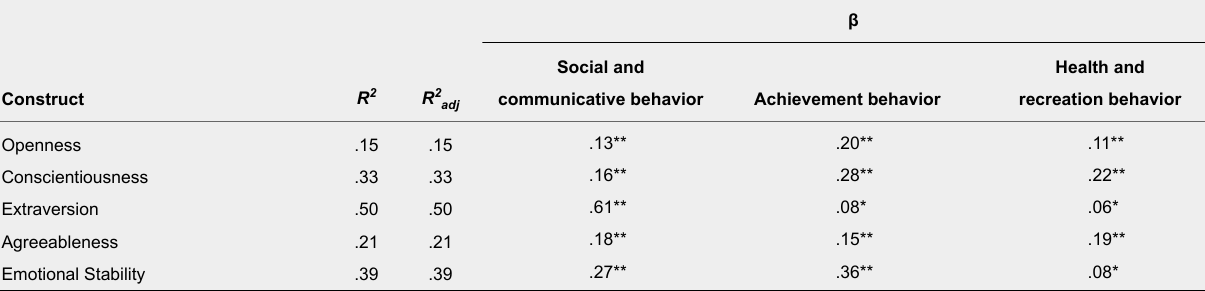
β Social and Health and communicative behavior Achievement behavior recreation behavior